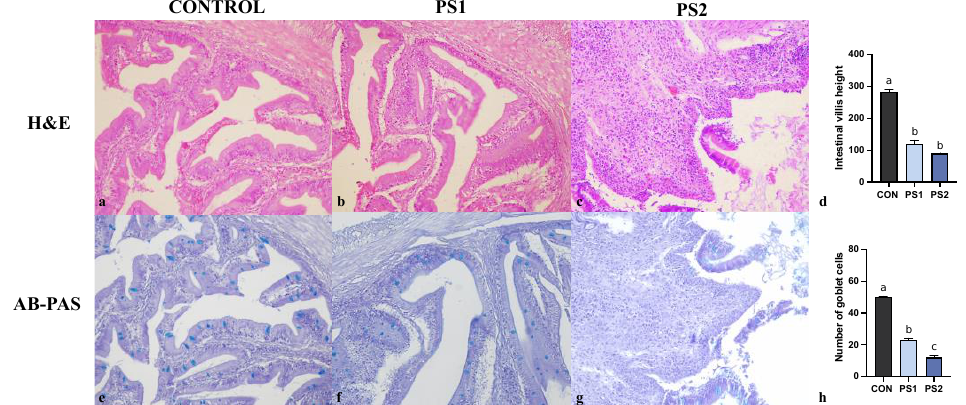
Figure 2. Representative microphotographs of posterior intestine (PI) of gilthead seabreams fed with control diet ( a , e ) and PS-MPs 25 mg/kg b.w./day ( b , f ) and 250 mg/kg b.w./day ( c , g ). Haematoxylin & eosin (H&E) staining is shown in panels ( a – c ) (original magnification, 20×). Alcian Blue-Periodic Acid Schiff’s (AB -PAS) staining is reported in panels ( e – g ) (original magnification, 20×). Panels ( d , h ) show the average of intestinal villi height ( μ m) and the number of goblet cells, respectively. All data are shown as mean ± S.E.M. Different letters indicate significant differences among treatments (at least p < 0.05).